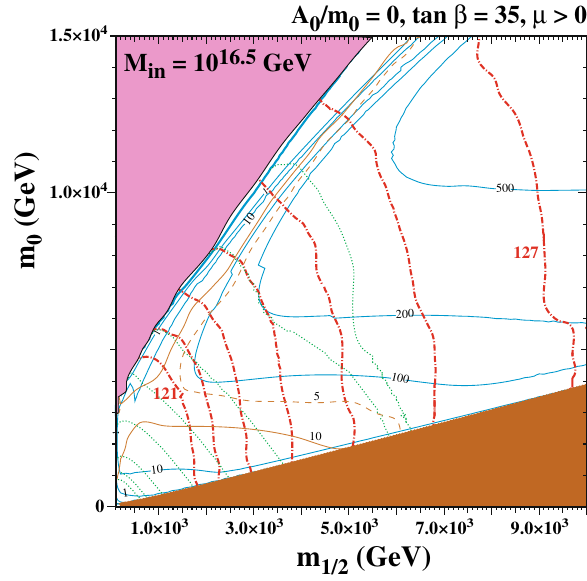
without electroweak symmetry breaking are shaded brown and pink, respectively. The contours are as in Fig. 1, with the addition of contours = 10 36 years in the left panel for τ p = 2 × 10 36 years and τ p − σ τ p